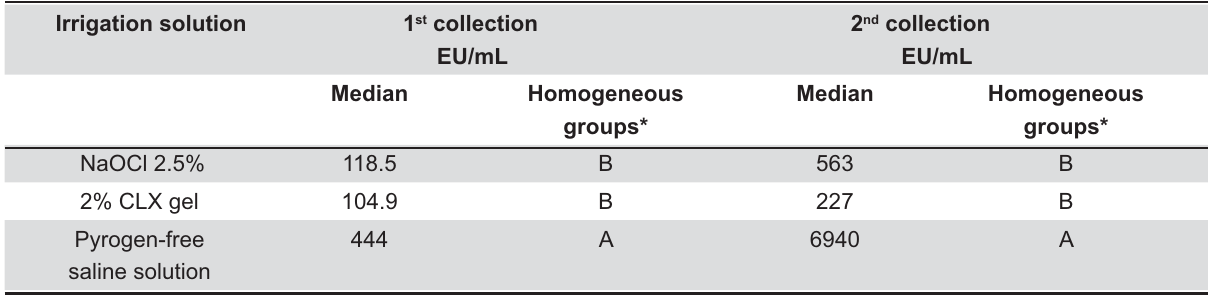
Table 2- Descriptive statistics of the median and homogeneous groups of quantity of endotoxin of E. coli (EU/mL) on the (cid:17)(cid:7)(cid:12)(cid:9)(cid:10)(cid:14)(cid:8)(cid:3)(cid:10)(cid:12)(cid:6)(cid:13)(cid:25)(cid:8)(cid:3)(cid:10)(cid:13)(cid:25)(cid:11)(cid:11)(cid:6)(cid:13)(cid:9)(cid:4)(cid:25)(cid:8)(cid:12)